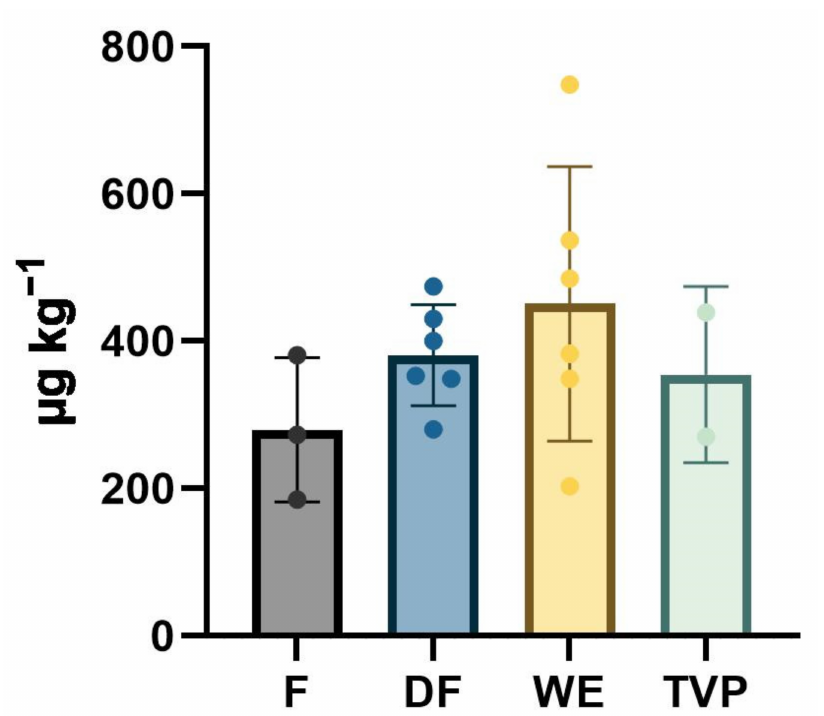
Figure 1. Bar chart of the acrylamide level in the investigated PBPIs divided by classes. F, flours; DF, dry fractionation; WE, wet extraction; TVP, texturized vegetable